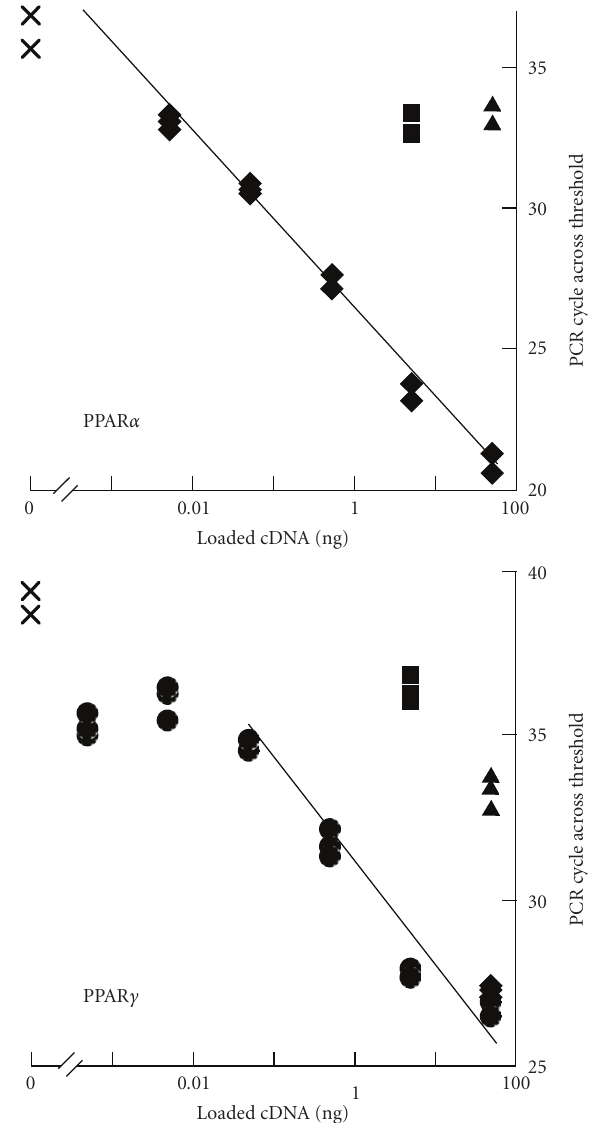
Figure 3: Measurement of mRNA levels of PPAR α (upper panel) and PPAR γ (lower panel) with real-time semiquantitative PCR. Total RNA (1 μ g) extracted from white adipose tissue ( ), liver ( (cid:2) ), BMMC ( (cid:3) ), and RBL-2H3 mast cells ( (cid:4) ) was supplemented with 50 pg of chloramphenicol acetyltransferase RNA and then reverse-transcribed. The indicated amounts of cDNA were applied to real-time PCR. PCR performed without cDNA was used as a negative control ( × ) of the reaction. Data are presented as the number of PCR cycles to cross the threshold. Messenger RNA levels in these tissues were extrapolated from the PCR cycle of the liver for PPAR α or white adipose tissue for PPAR γ and then corrected by the chloramphenicol acetyltransferase cDNA content in each sample and presented in the manuscripts [13,